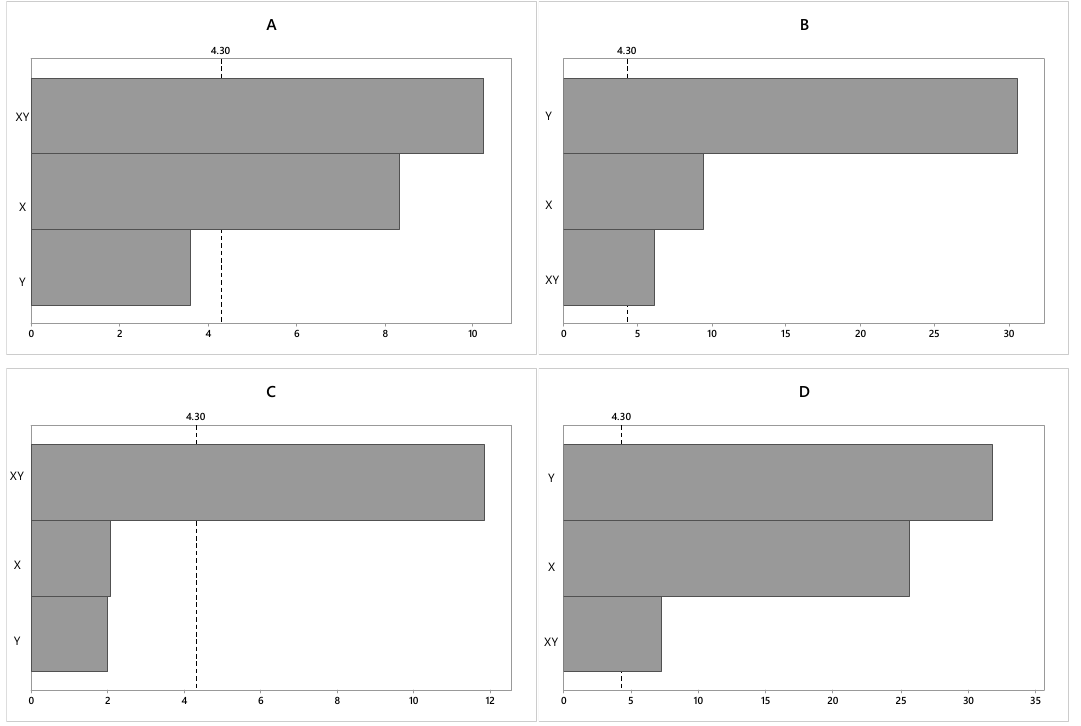
Figure 4. Effect of the independent variables (X: Light intensity and Y: Nitrogen concentration) and their interaction (XY) on lipid content (%), for a confidence level of 95%. ( A ) Synechocystis sp. CACIAM05; ( B ) Microcystis aeruginosa CACIAM08; ( C ) Pantanalinema rosaneae CACIAM18; ( D ) Limnothrix sp. CACIAM25.